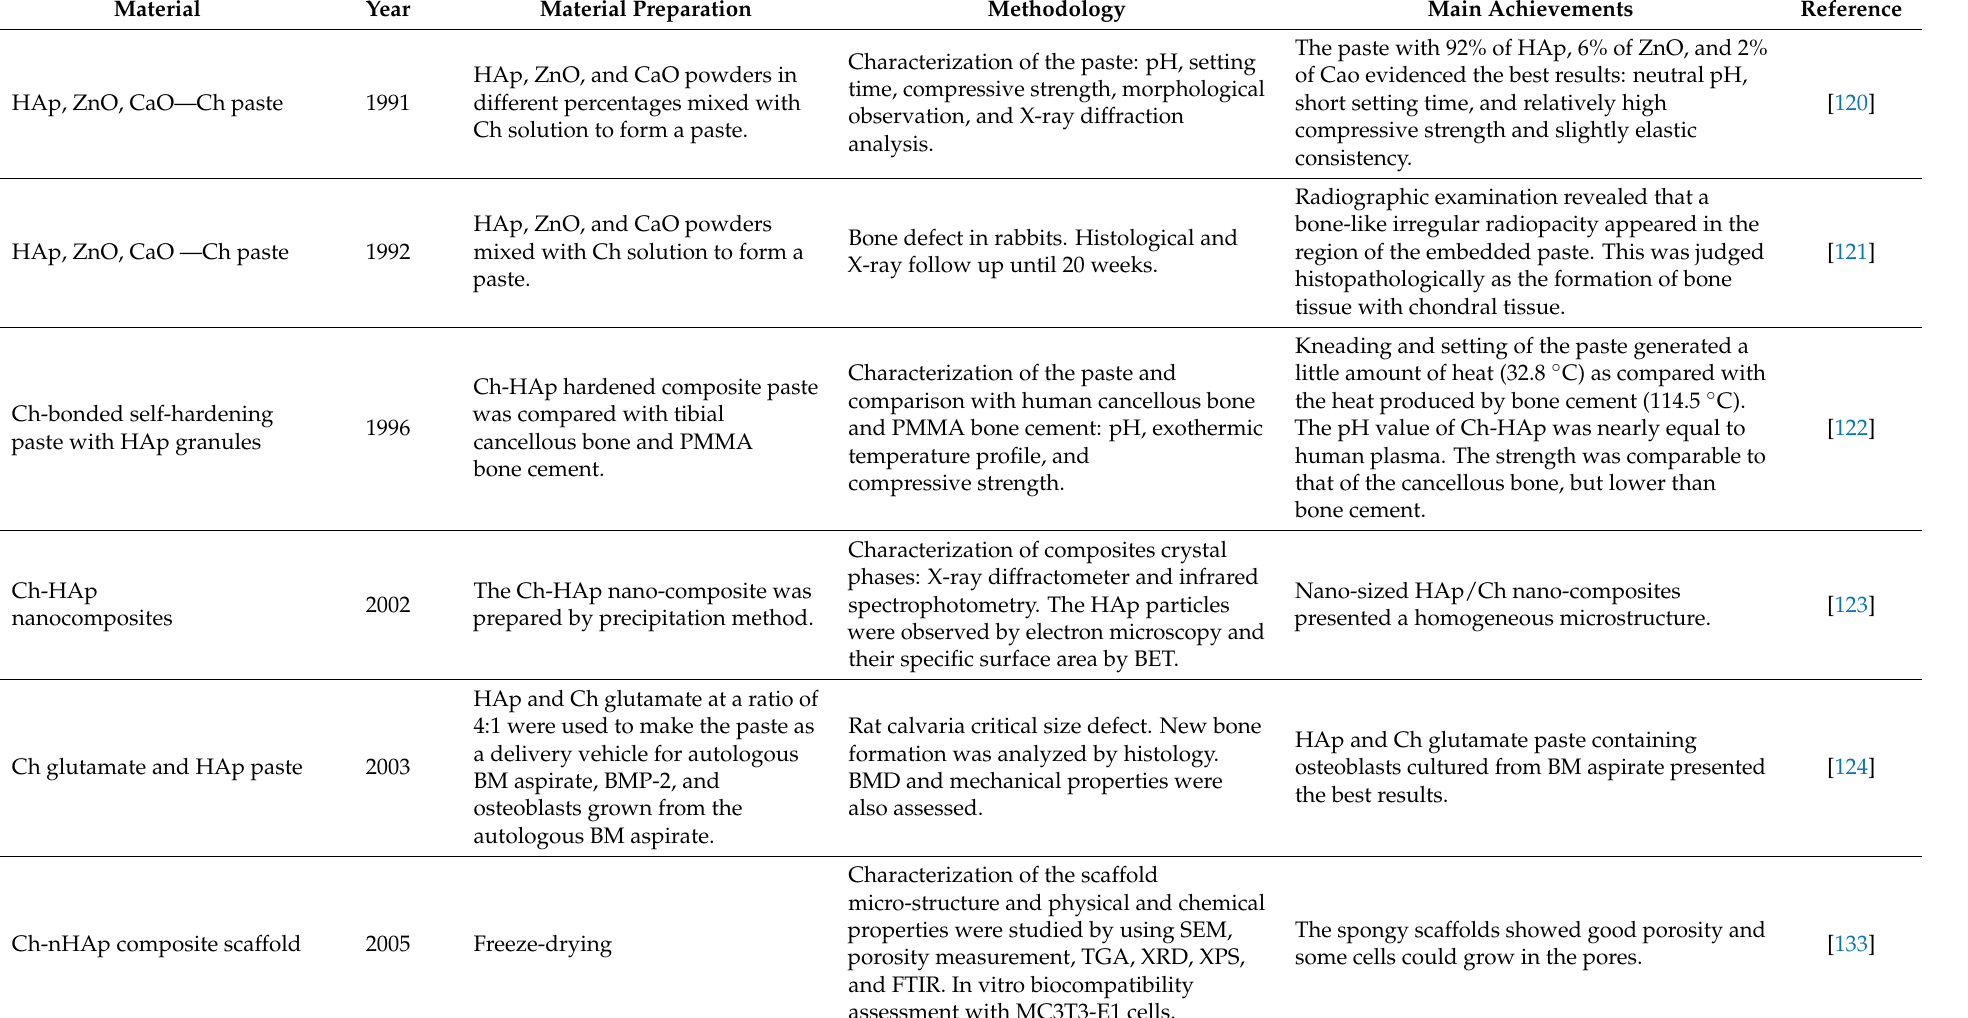
Table 3. Studies showing the combination of chitosan and hydroxyapatite-based materials for orthopedic and tissue engineering